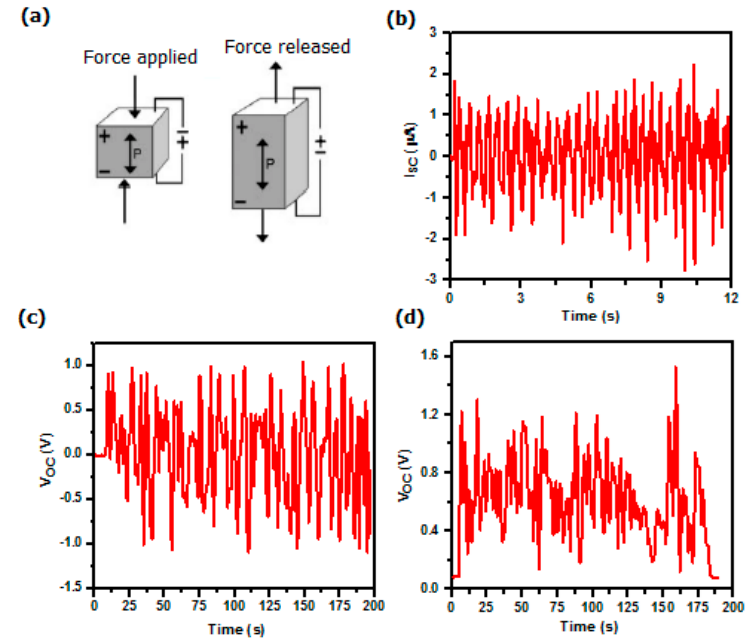
Figure 5. Performance of a simple piezoelectric nanogenerator by a compressive force: ( a ) a force applied and released on a simple piezo film ( b ) short-circuit current generated by a single piezo film ( c ) open circuit voltage generated during the bending and releasing modes ( d ) rectified open circuit voltage.